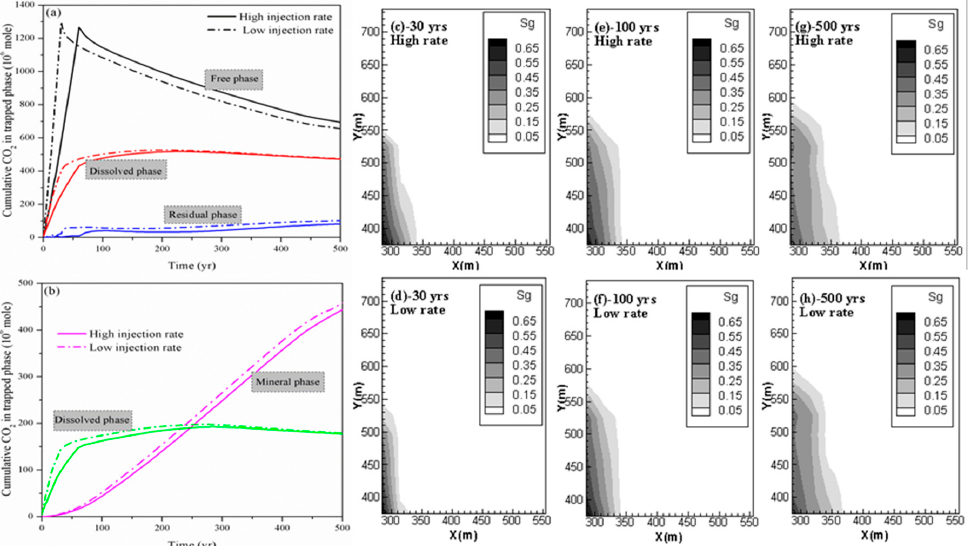
Table 3. Comparison of CO 2 amount in different phases for case 2 and case 3.